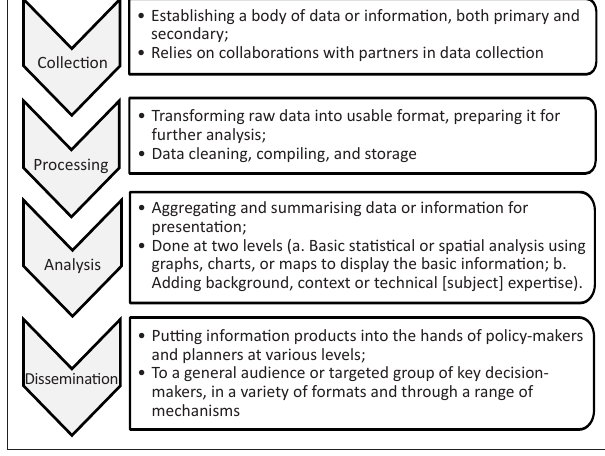
Figure 1 (adapted from OCHA 2006:2). All four stages are